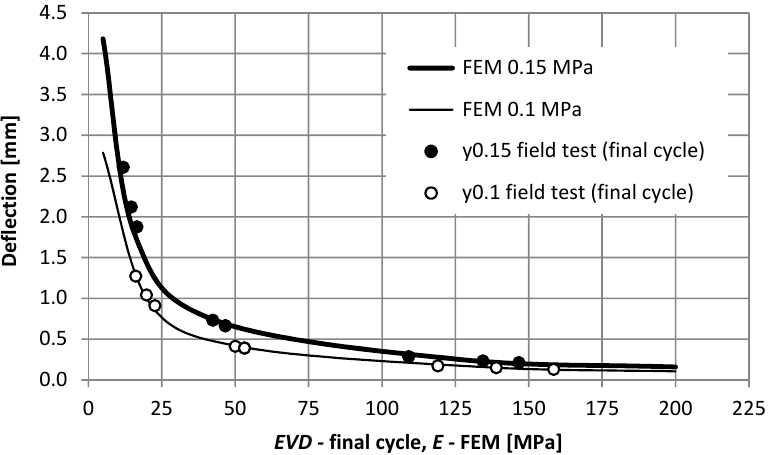
Figure 10. Comparison of the results of field tests and numerical calculations, taking into account moduli and displacements.